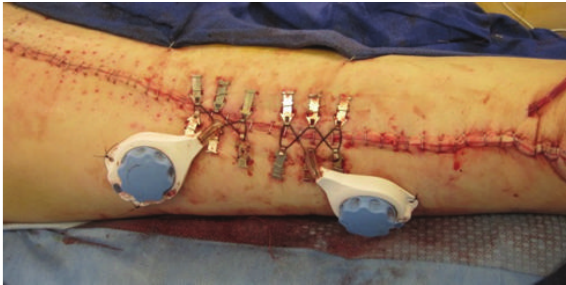
Figure 3: Primary closure obtained with utilization of two Derma- close systems.